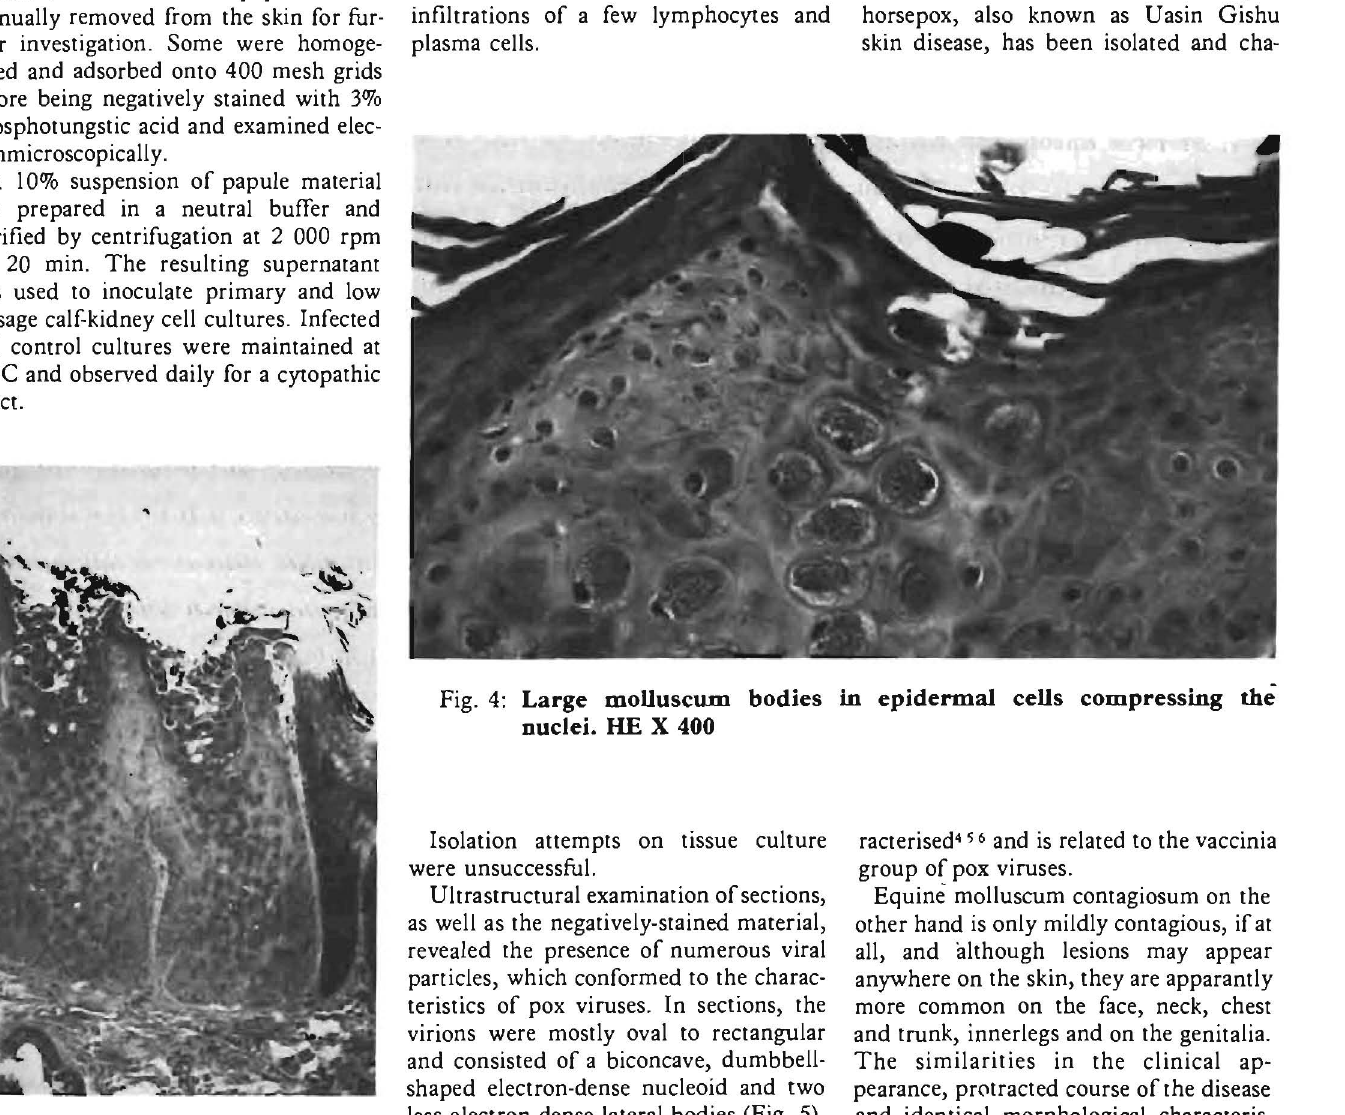
Fig. 3: Focal hyperplasia of stratum spinosum with molluscum bodies in the majority of the keratinocytes. Note release of cells containing molluscum bodies from the epidermal surface. HE X